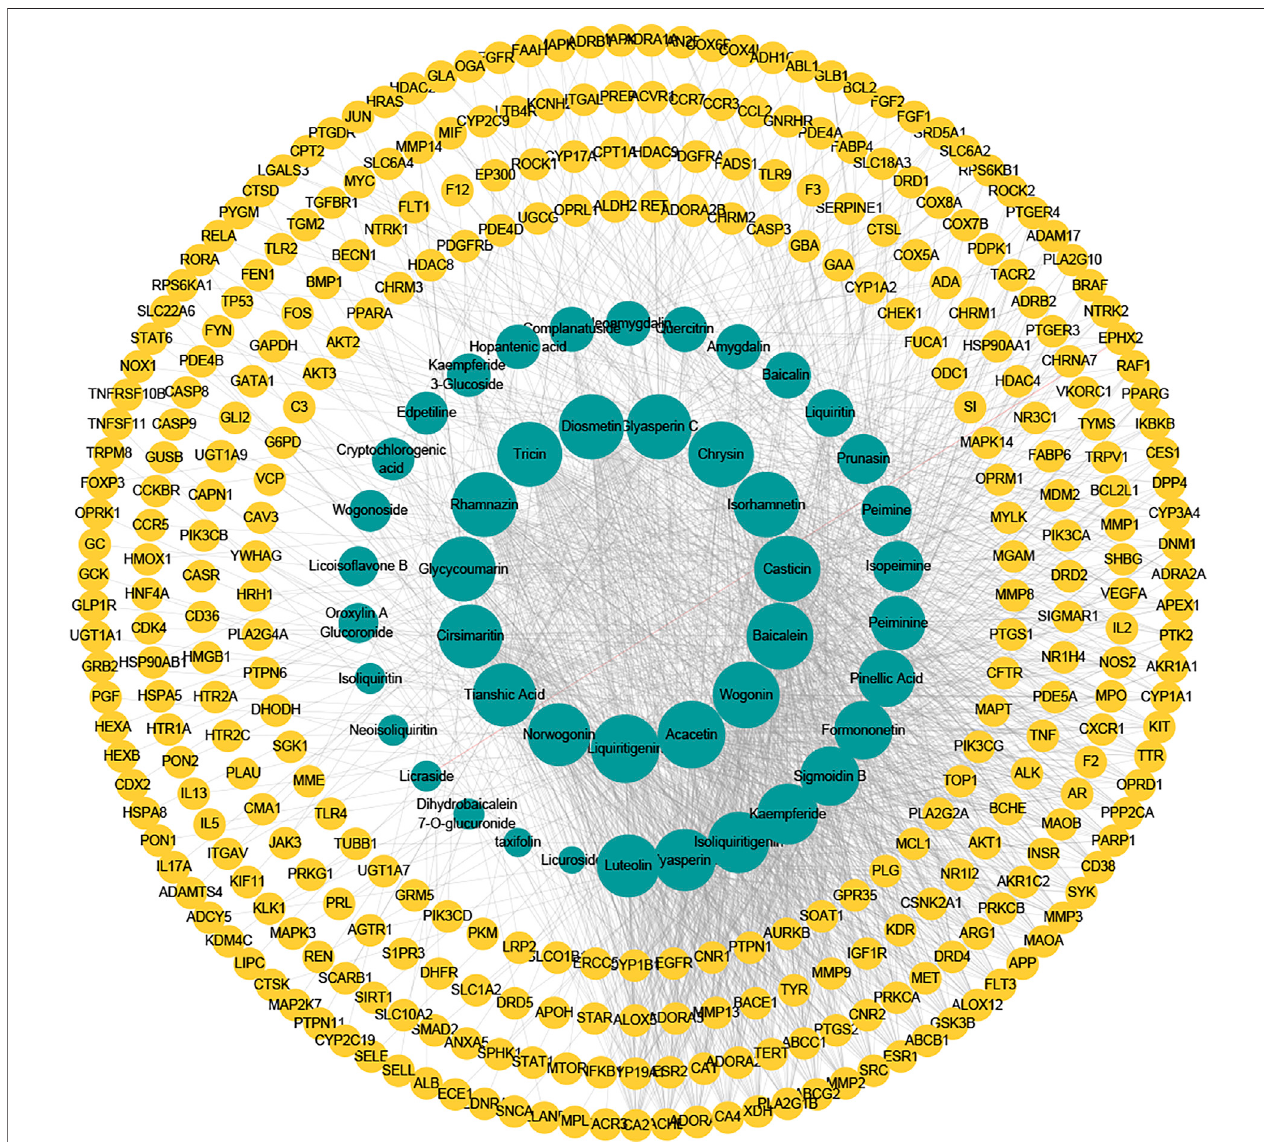
FIGURE 4 | Compound – target network. The potentially important targets and compounds may be found, which may play roles in immune and in fl ammatory response, and oxidative stress.